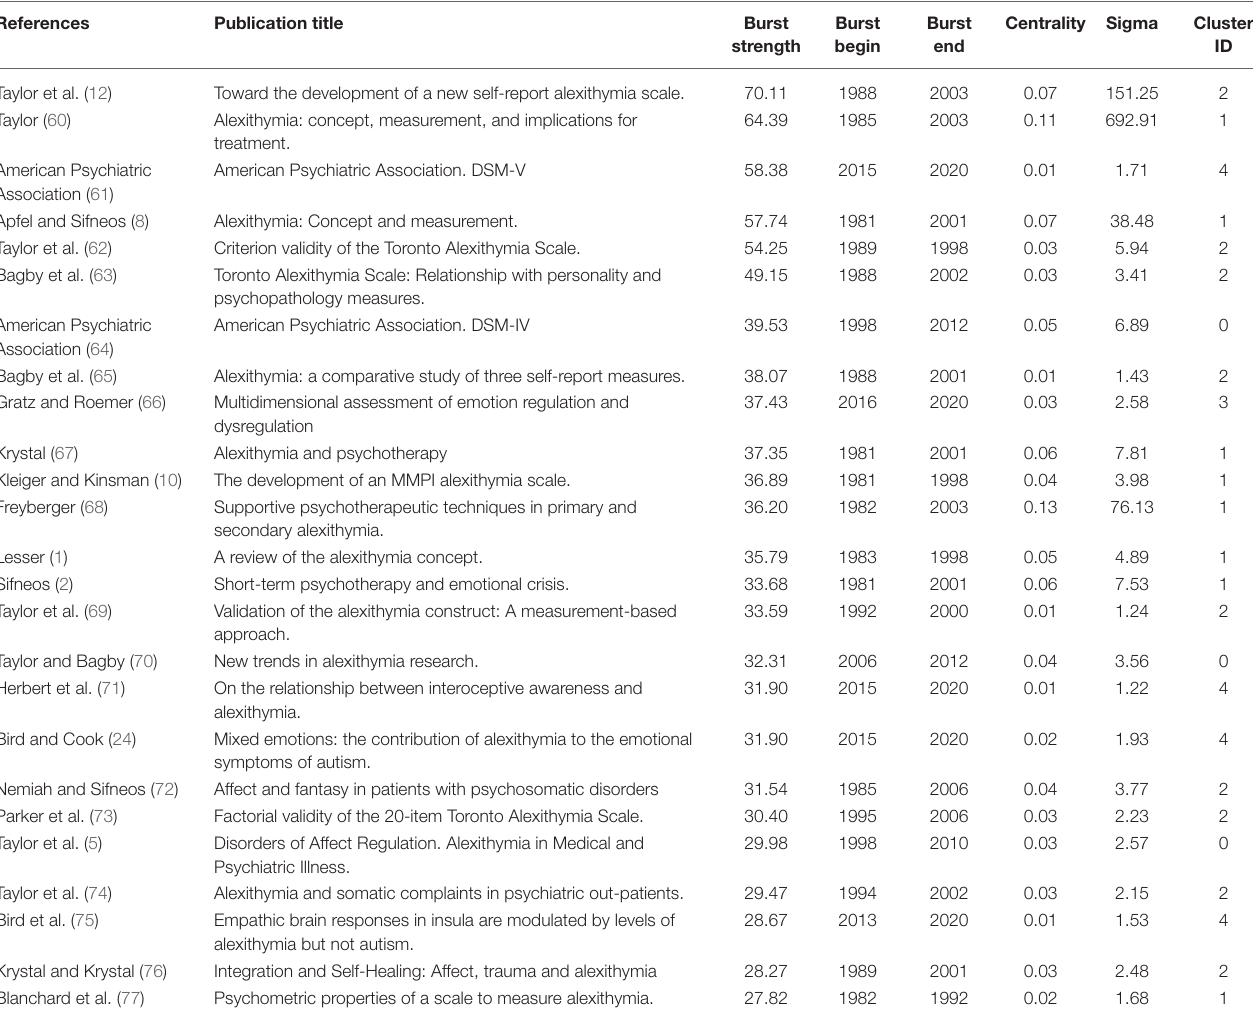
TABLE 2 | List of the top 25 documents for burst strength, estimated via document co-citation analysis